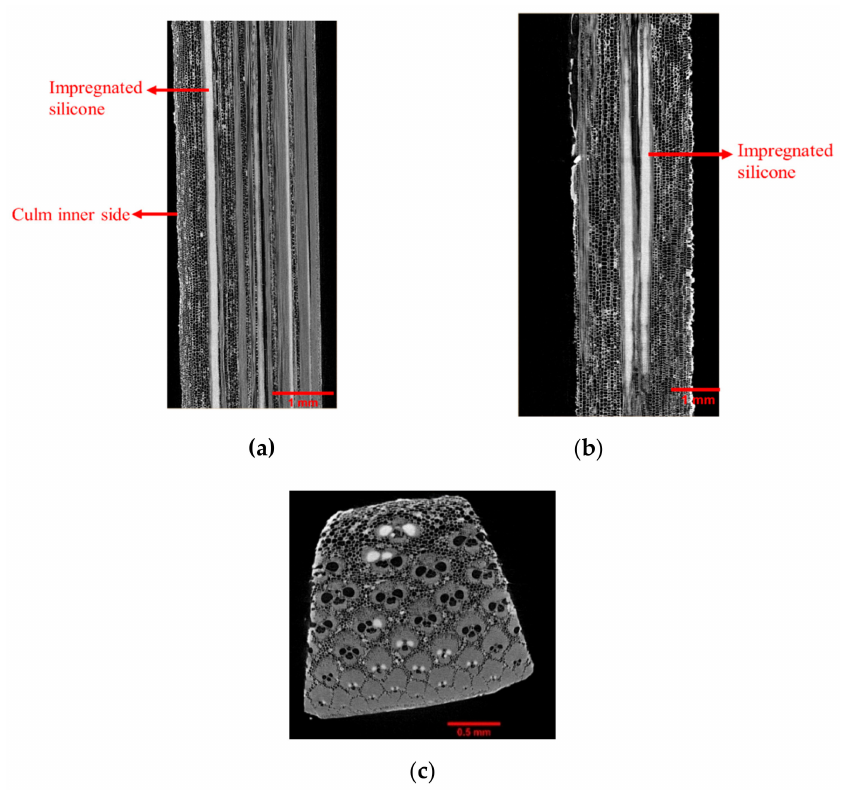
Figure 4. X-ray micro-CT images of plastinated bamboo. ( a ) front view, ( b ) side view, and ( c ) top view. Bright white contrast in vertical bundles denotes an impregnated silicone